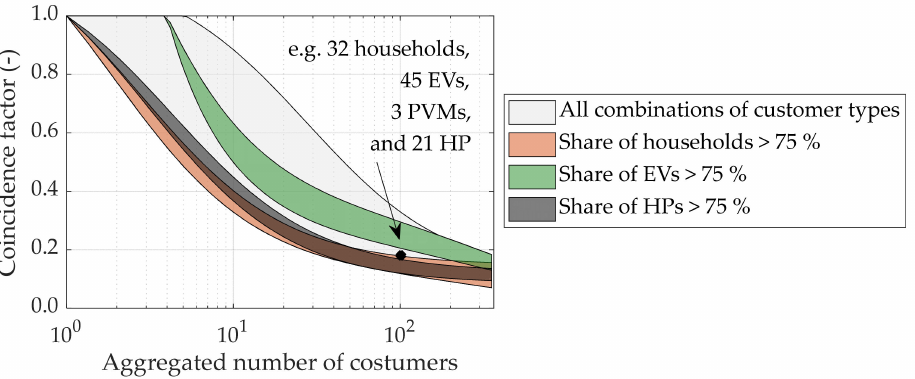
Figure 4. Novel coincidence factors considering temporal interdependences between various customer types: households, electric vehicles (EVs), photovoltaic modules (PVMs), and heat pumps